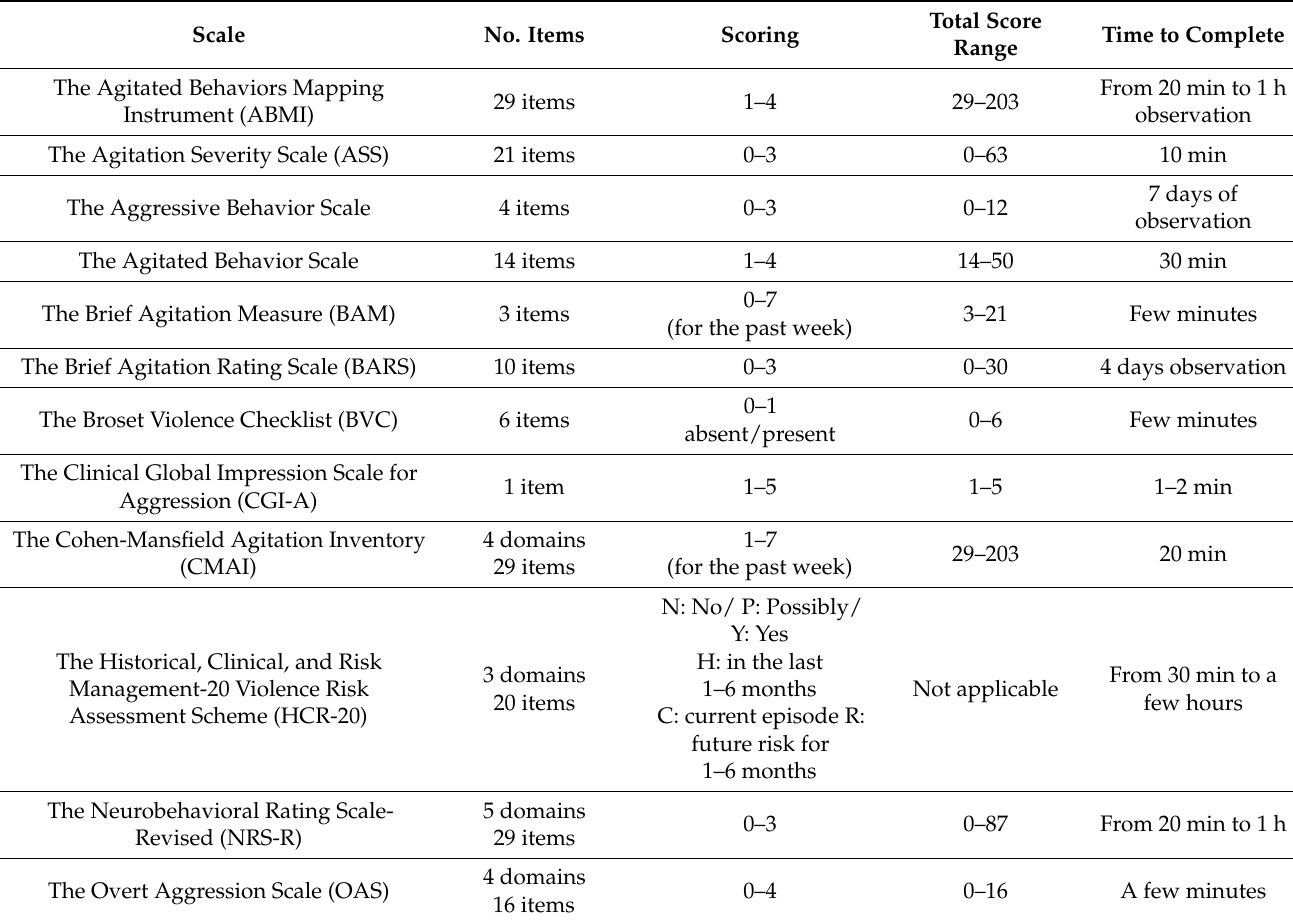
Table 1. Ratings scales for psychomotor agitation in emergency care